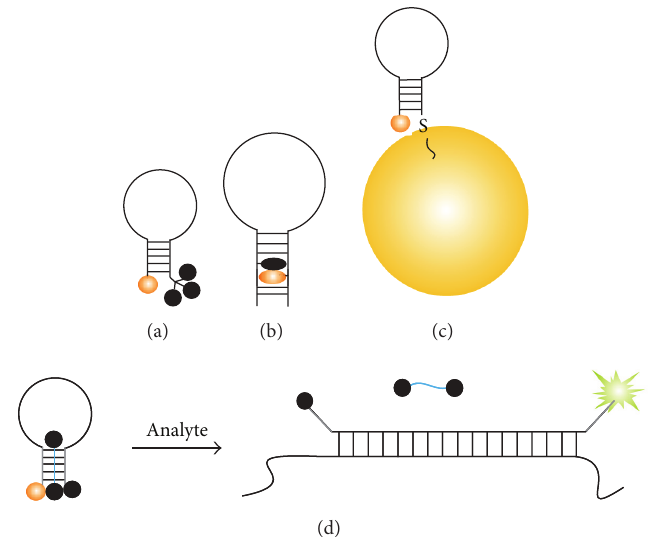
F 9: Strategies to reduce the background �uorescence of MB probes. (a) Superquenched MB probe contains more than one quencher [75]. (b) In-stem probe takes advantage of stacking interaction of stem base pairs with a �uorophore and a quencher dyes to